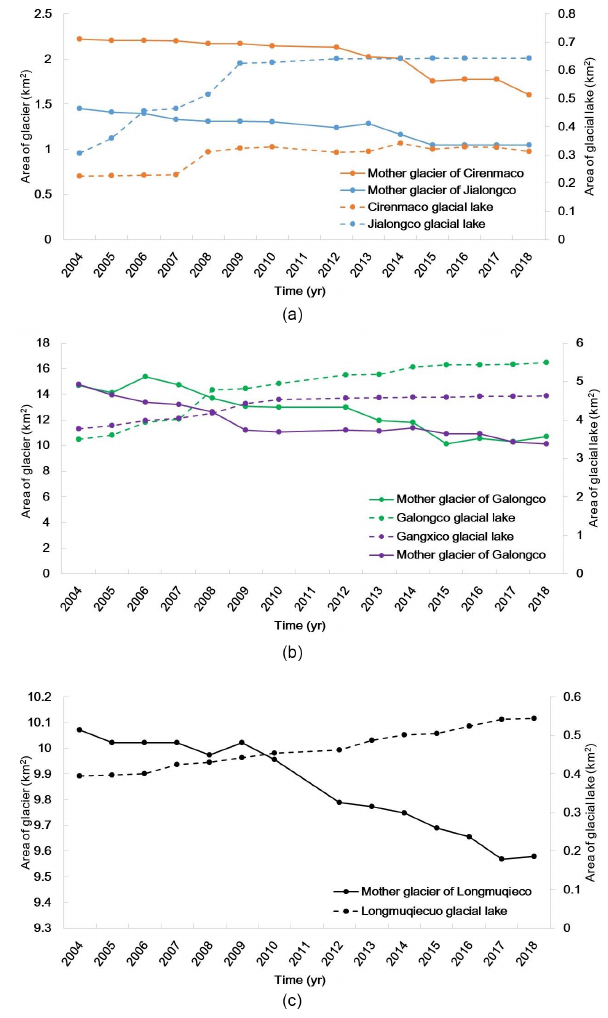
Figure 8. The retreat of the five typical glaciers, growth of five typ- ical glacial lakes, and rates of change in the Poiqu River